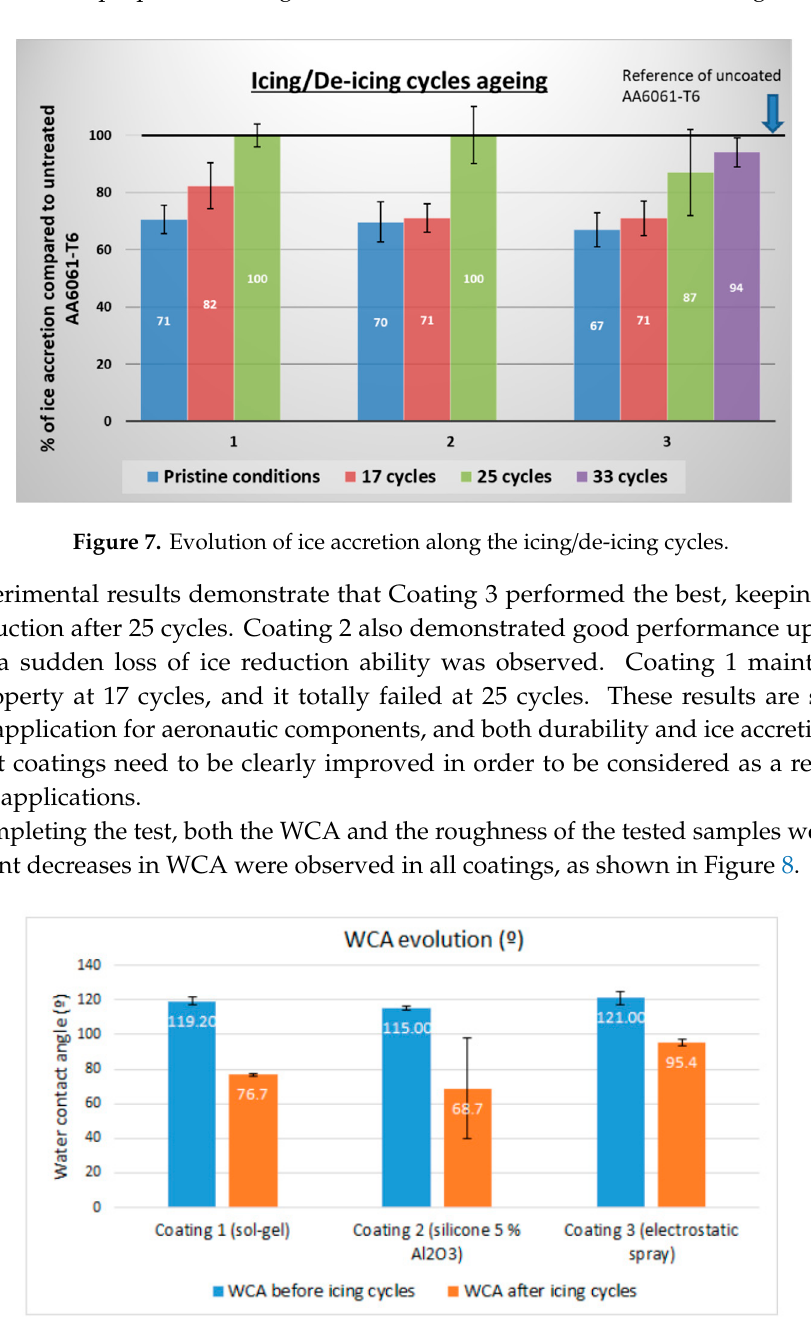
Figure 8. Evolution of WCA before and after the Icing/de-icing cycles.